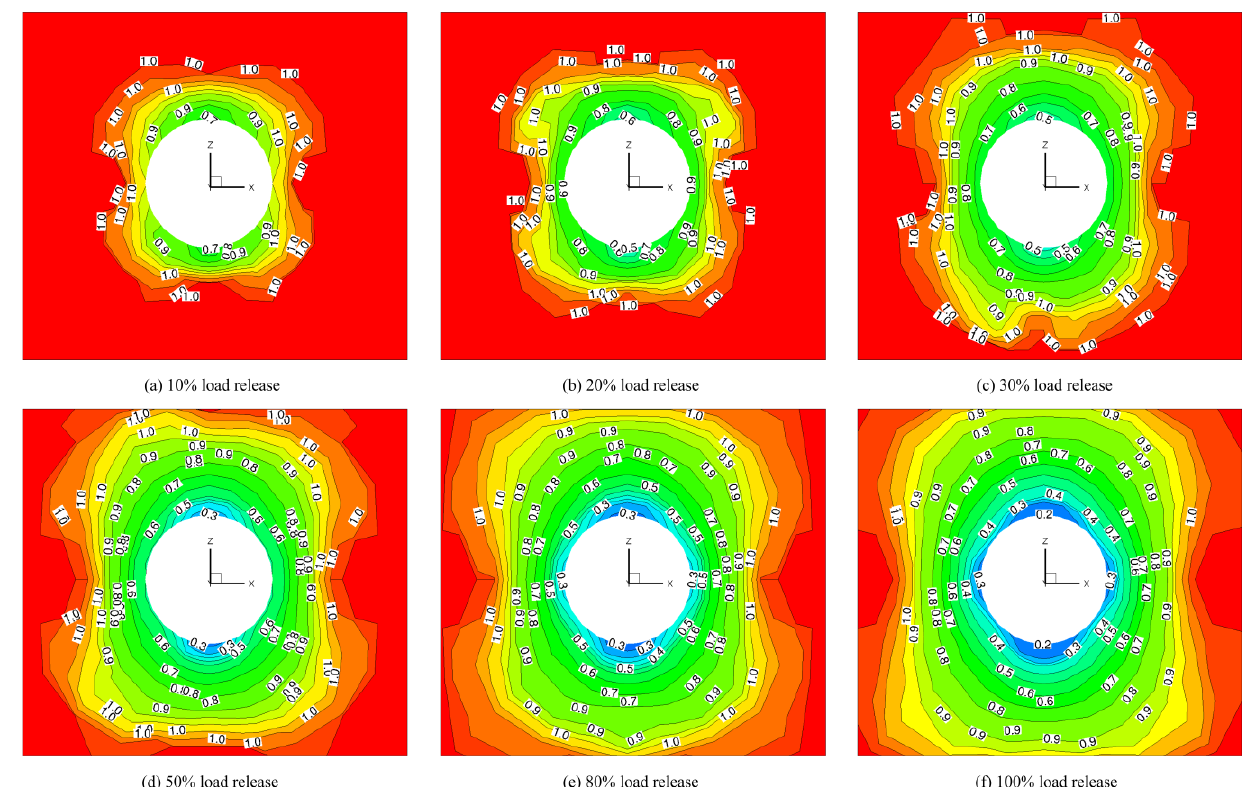
Figure 11. Distribution of acoustic wave velocity reduction coefficient of damaged rock around the